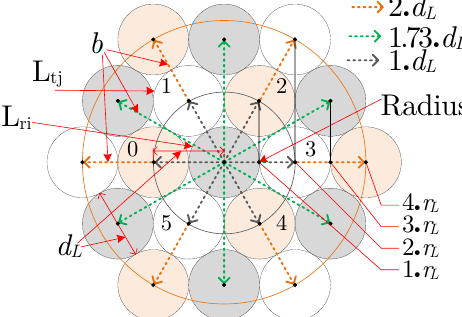
Figure 5. Micro-lenses hexagonal arrangement in the MLA.